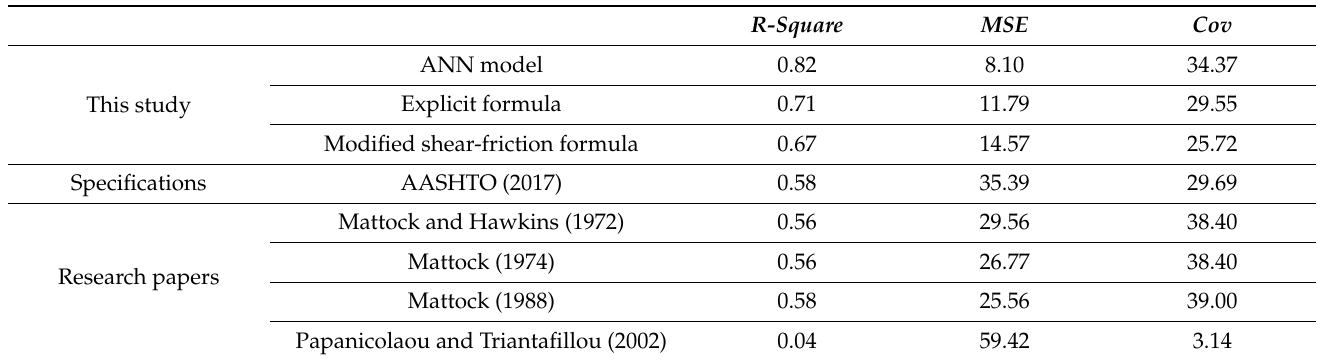
Table 8. Relevant formulas in